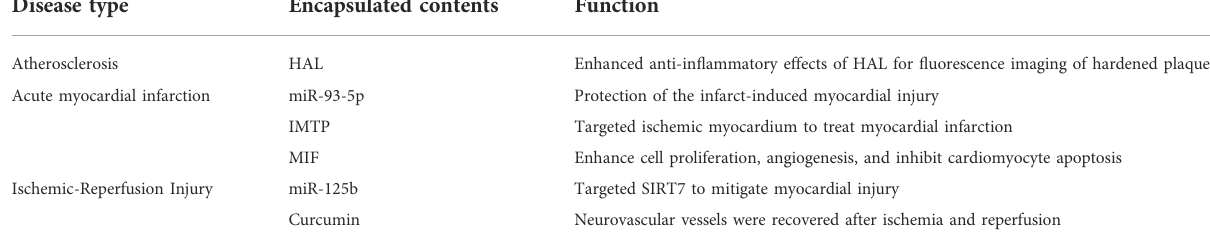
TABLE 3 Engineered exosomes in the cardiovascular